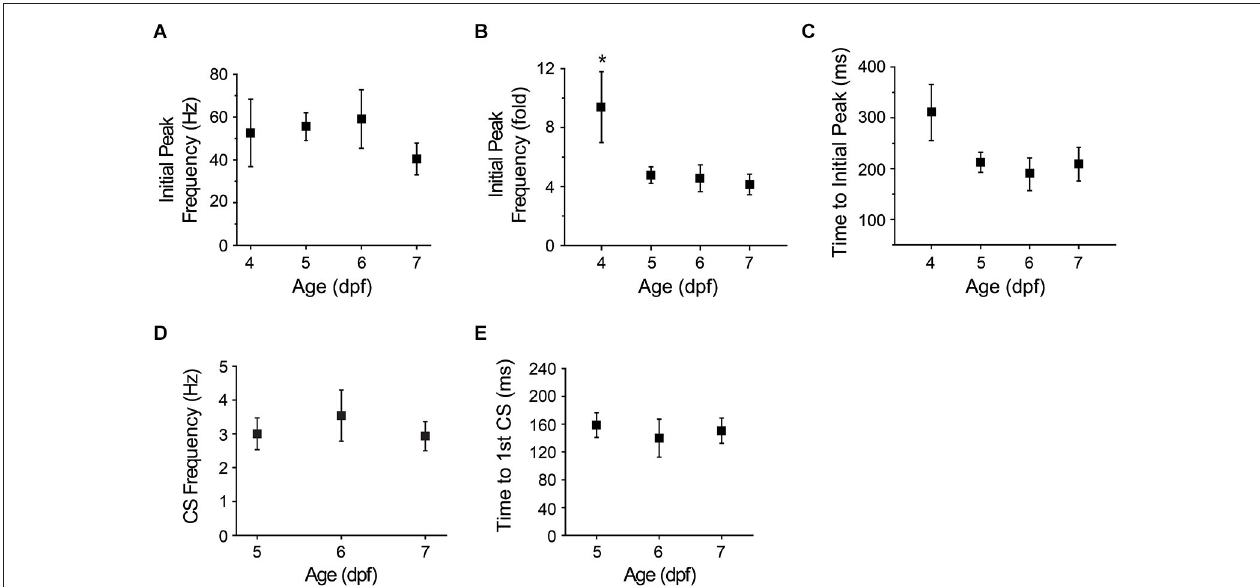
the LED and the initial peak in simple spike frequency has been plotted vs. age. The latency decreased from 311 ± 55 ms at 4 dpf to 212 ± 19 ms at 5 dpf, 189 ± 32 ms at 6 dpf and 209 ± 33 ms at 7 dpf ( n = 6, 14, 9 and 11 cells at 4, 5, 6 and 7 dpf, respectively, 5–11 animals; Spearman’s rank correlation, r = − 0.8). (D) The graph shows the complex spike frequency measured in the first 500 ms after turning off the LED at 5–7 dpf ( n = 13–28 trials from 8–10 cells, 5–9 animals). Values did not differ significantly. (E) The graph shows the latency between turning off the LED and the first complex spike at 5–7 dpf. Values did not differ significantly ( n = 9–24 trials from 8–10 cells, 5–9 animals). Trials in which sudden darkness did not evoke complex spikes within 500 ms post-stimulation were excluded from the